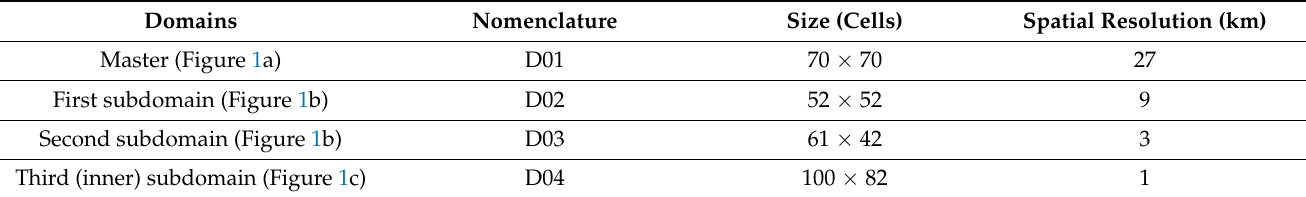
Table 2. Configuration of the domains for modeling the meteorology and air quality in Cuenca.